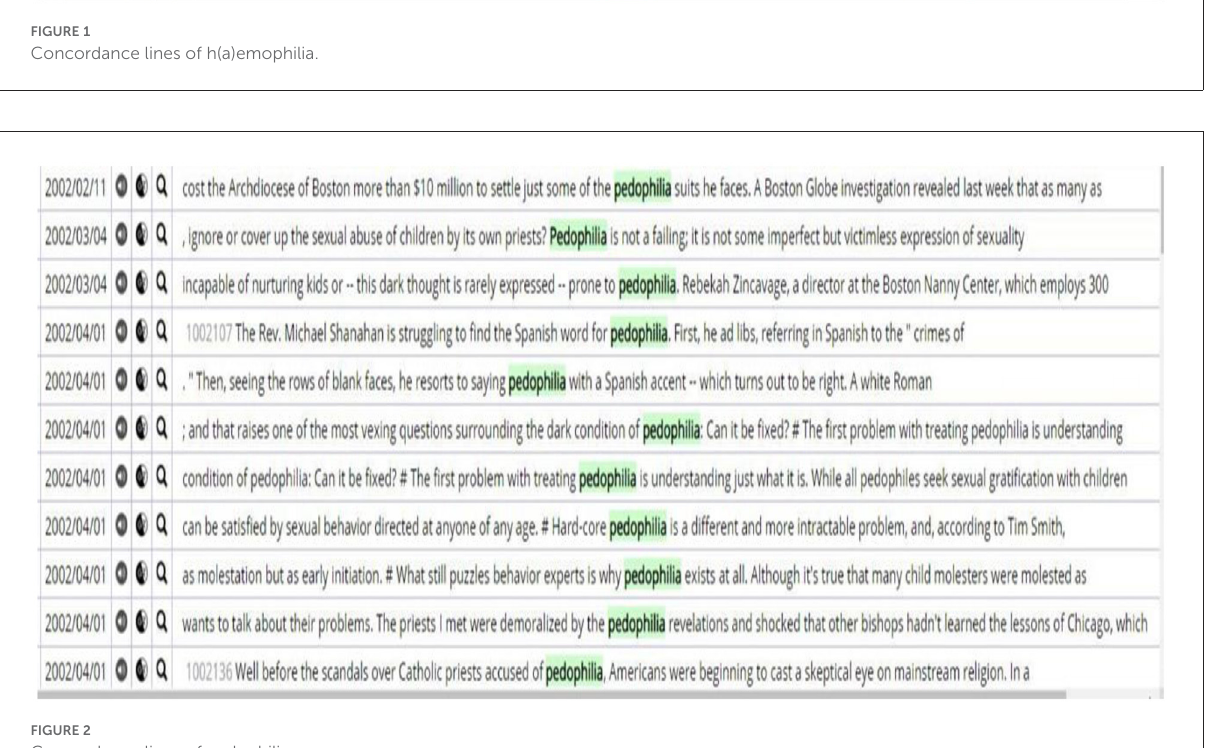
FIGURE2 Concordance lines of